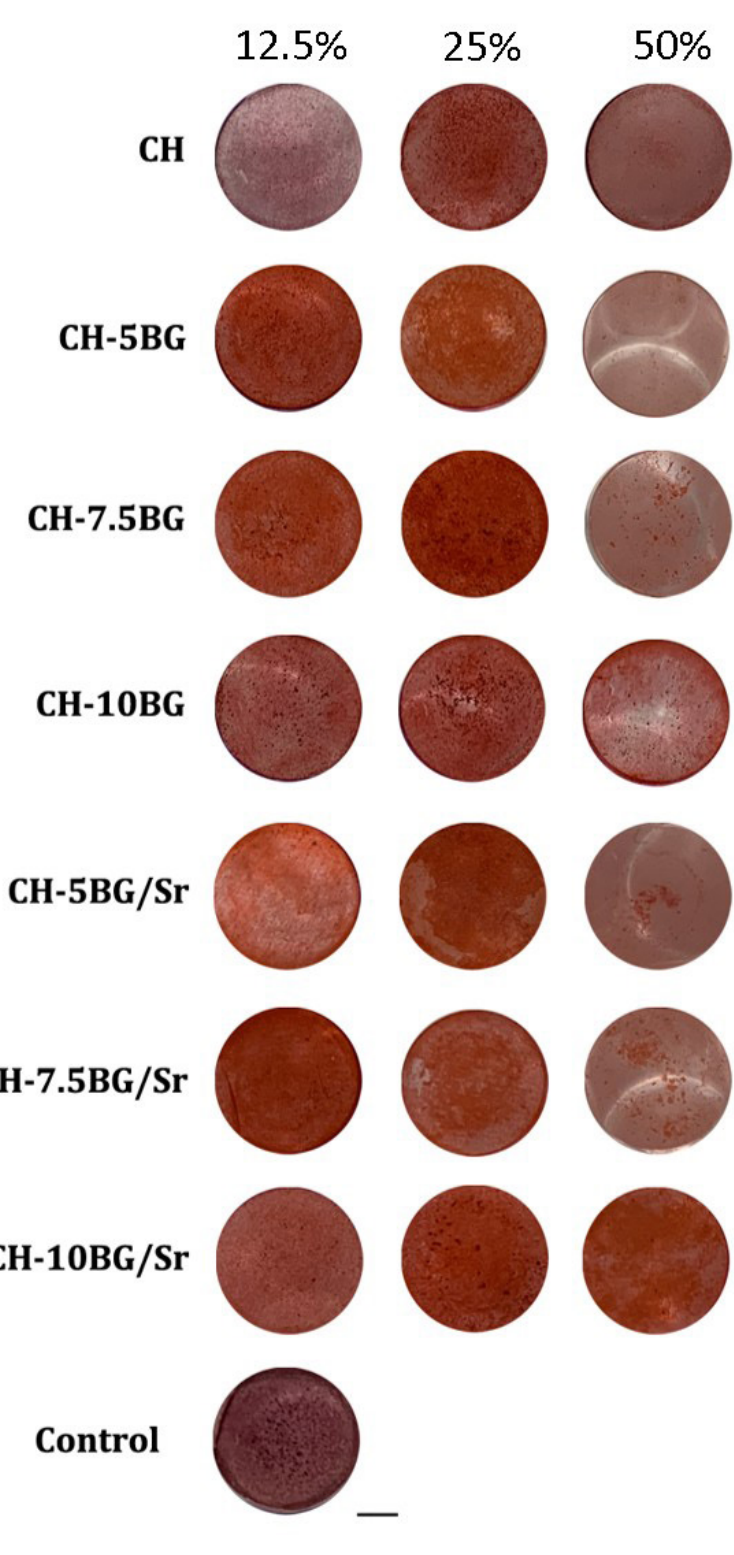
Figure 10. Macroscopic aspects of alizarin red marking in osteoblastic cultures of the MC3T3-E1 strain exposed to extracts of compositions based on calcium aluminate cement (CH) containing different contents of bioactive glass (BG) and strontium (Sr) in concentrations of 12.5%, 25% and 50%or in their absence (control) for 14 days. Scale bar = 200